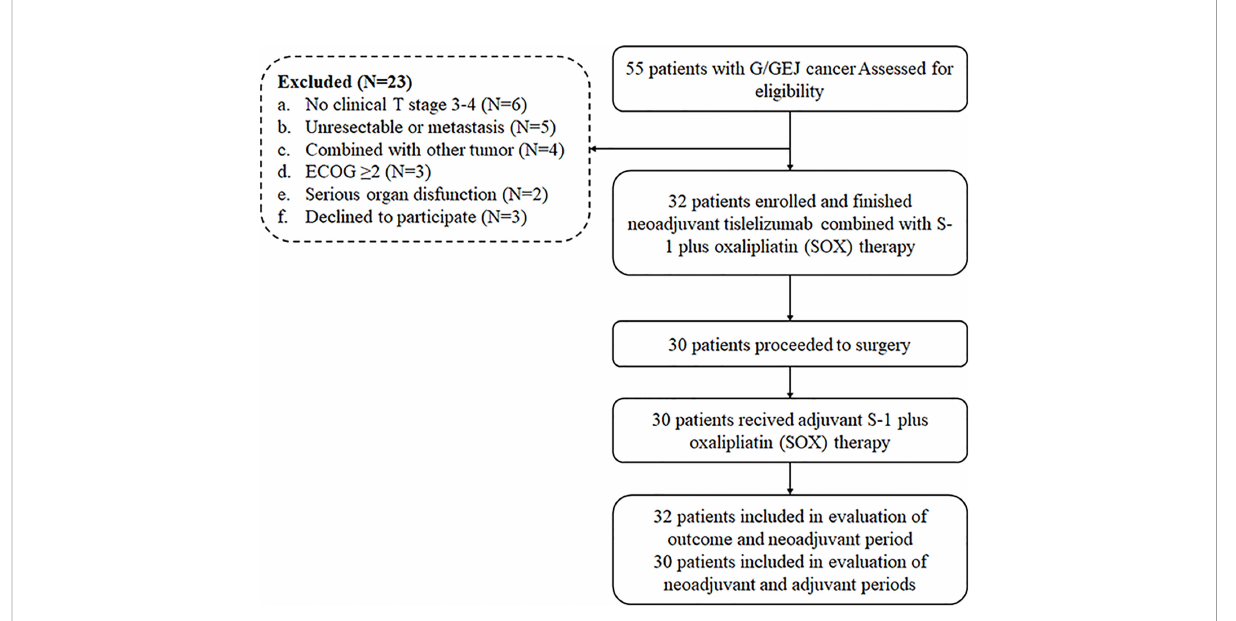
FIGURE 1 (A) The fl owchart of the neoadjuvant immunotherapy – chemotherapy